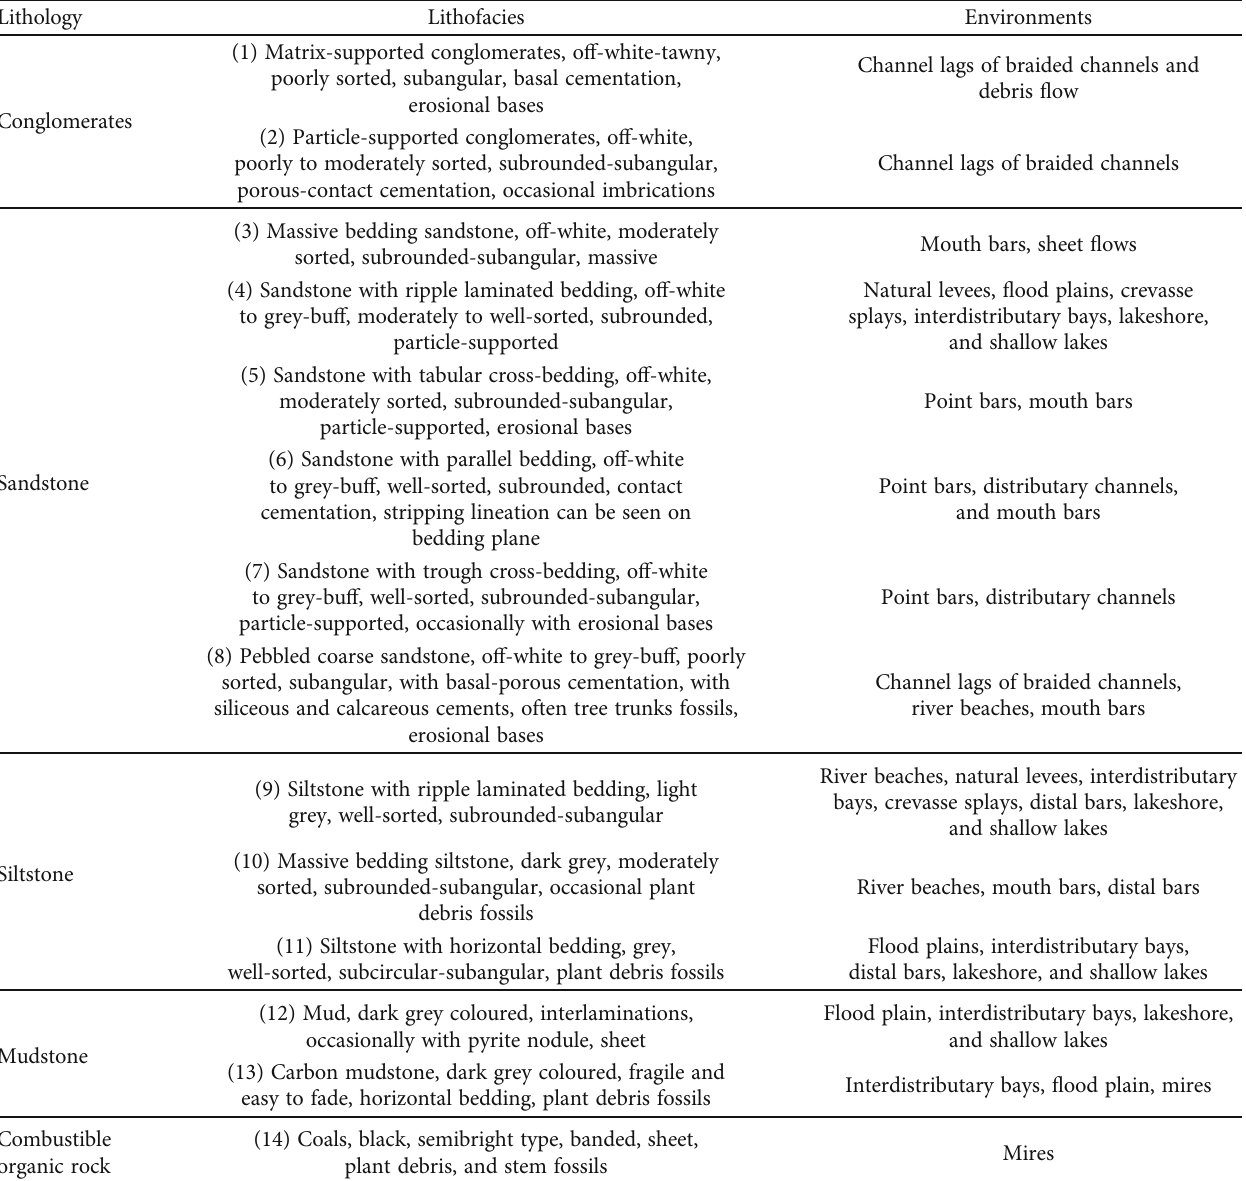
Table 1: Lithofacies of the middle member of Xishanyao Formation of the western Dananhu coal fi eld. Lithology